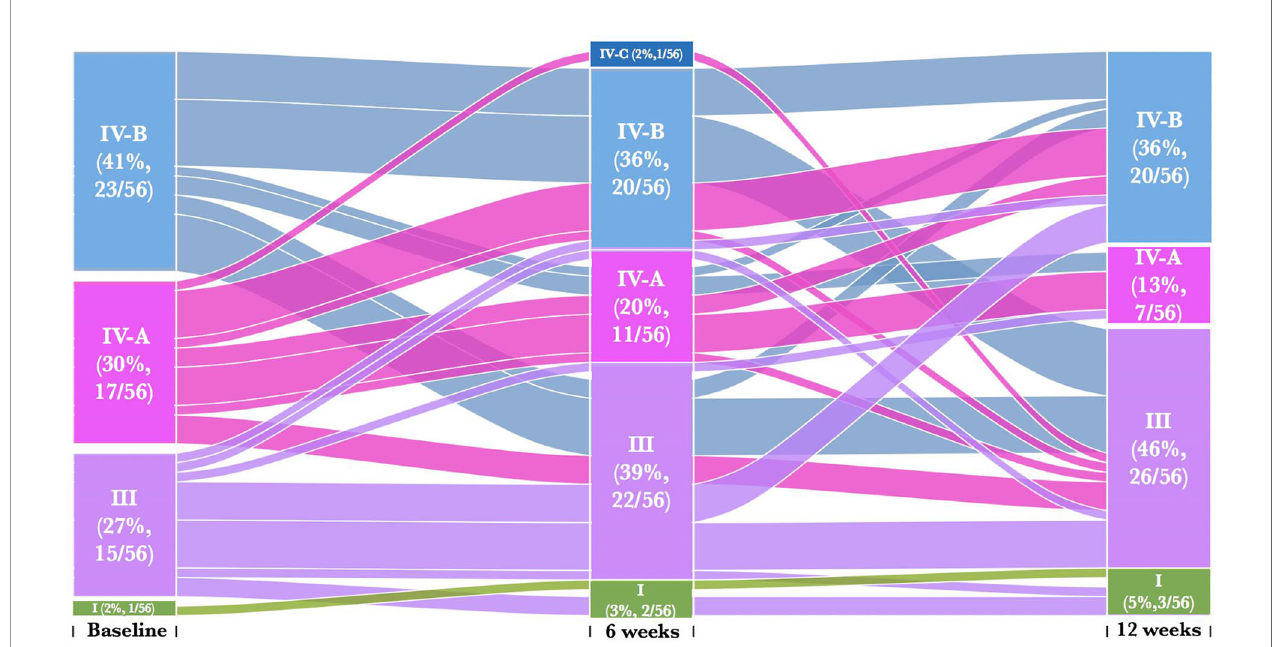
FIGURE 3 | Alluvial diagrams are showing participant transition (n=56) between CSTs pre- and post-treatment. CST I (green) lacked a consistent dominant species, but all communities included L. crispatus , CST III (purple) L. iners dominance, CST IV-A (pink) had diverse bacterial communities dominated by BVAB1, CST IV-B characterized by G. vaginalis dominance and CST IV-C characterized by an even community with moderate abundance of Prevotella bivia